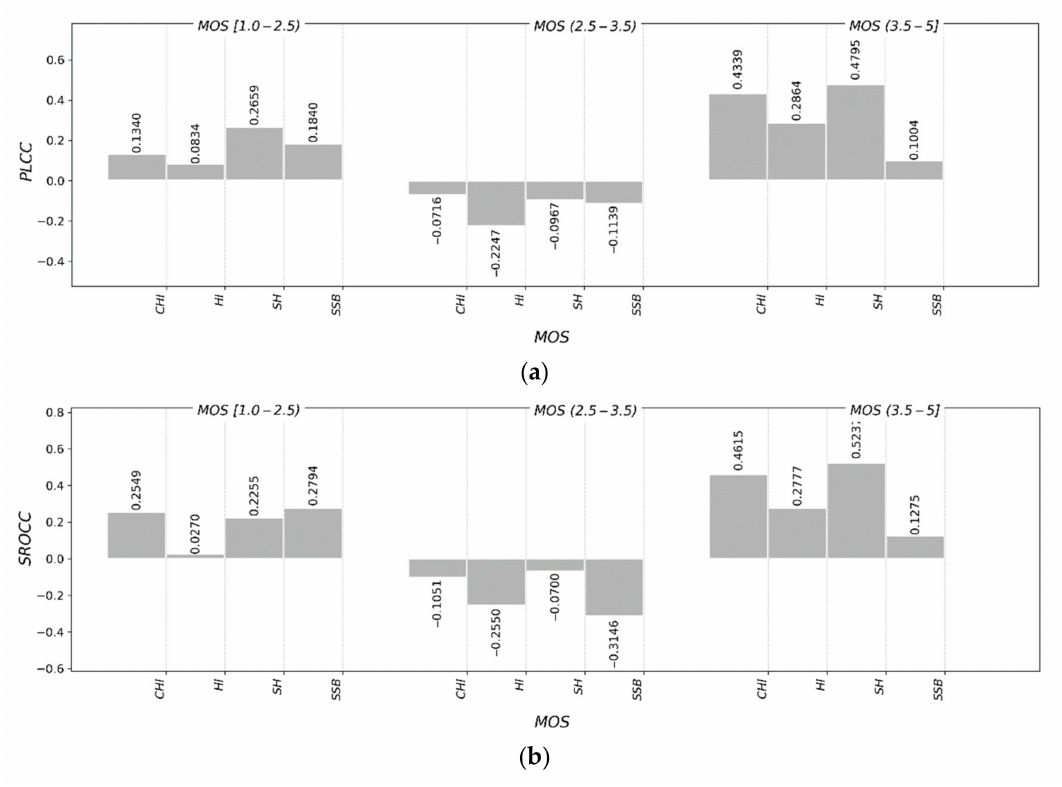
Figure 7. Comparison of the correlation values between di ff erent quality groups of MOS scores and internal validation scores ( CHI , HI , SH , SSB ): ( a ) PLCC , and ( b ) SROCC . Table 11. Correlation between di ff erent quality groups of MOS scores and external validation scores (the top three best results are highlighted for each quality